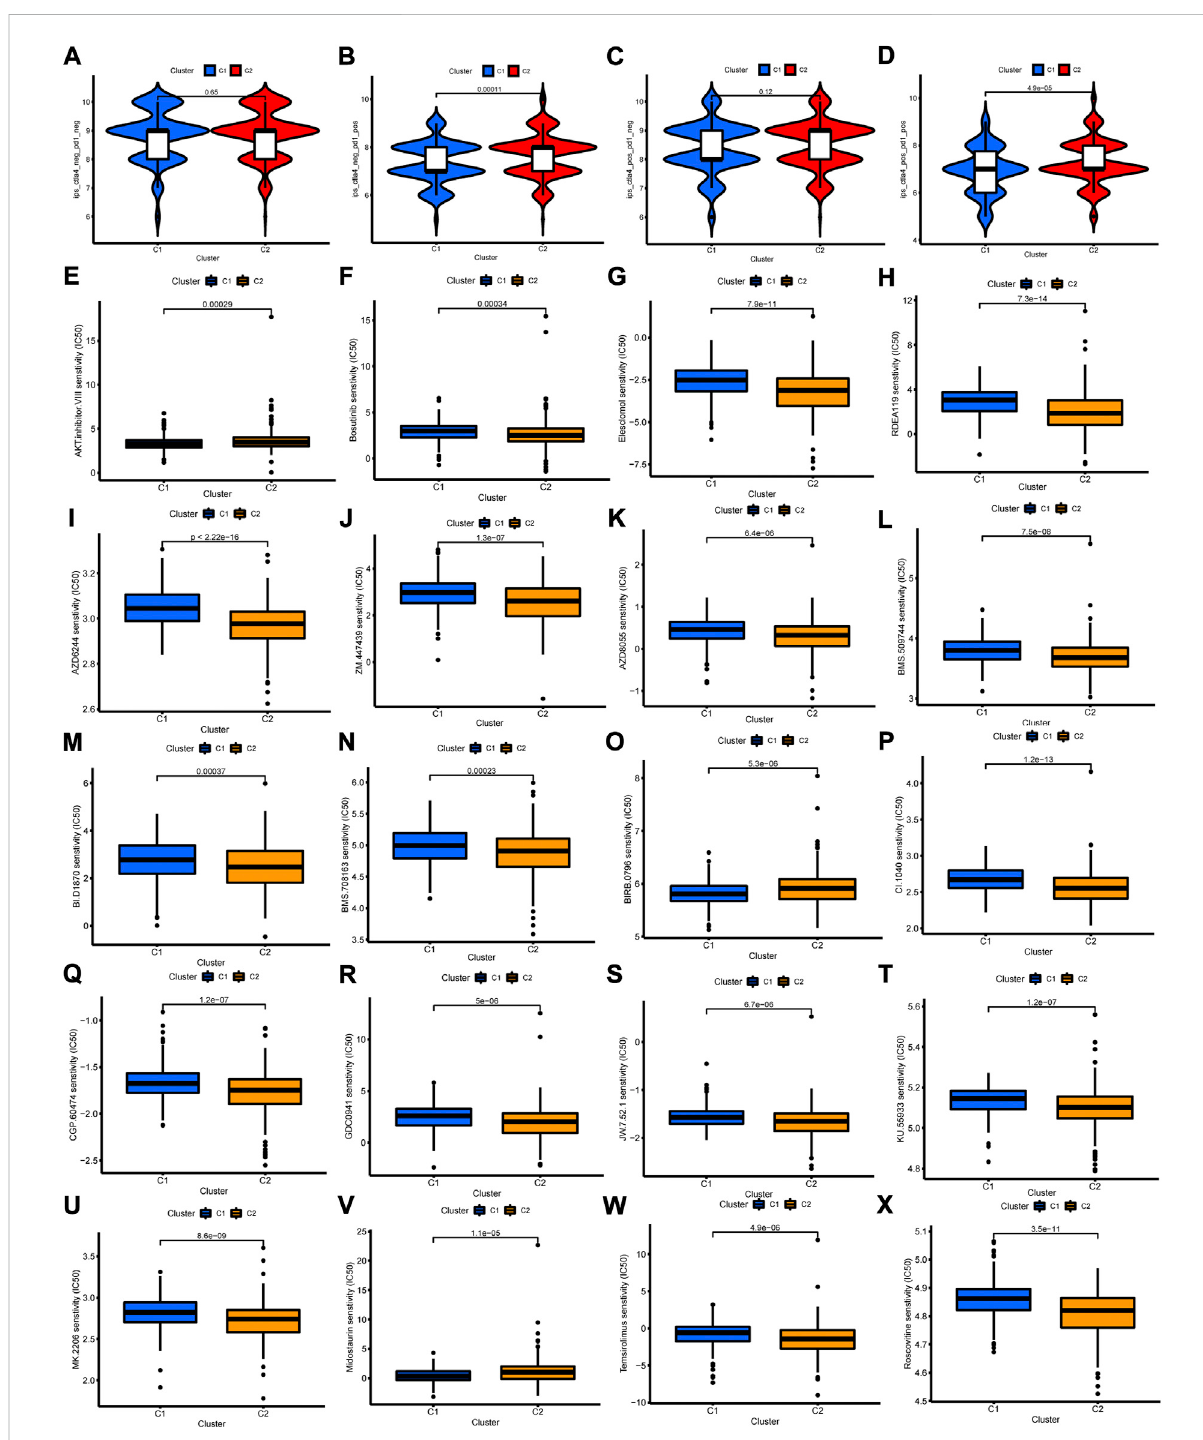
FIGURE 8 The Relationship of cuproptosis-related clusters with clinical treatment. (A – D) The IPS in the two clusters. (E – X) The IC50 of 20 anti-tumor drugs in the two